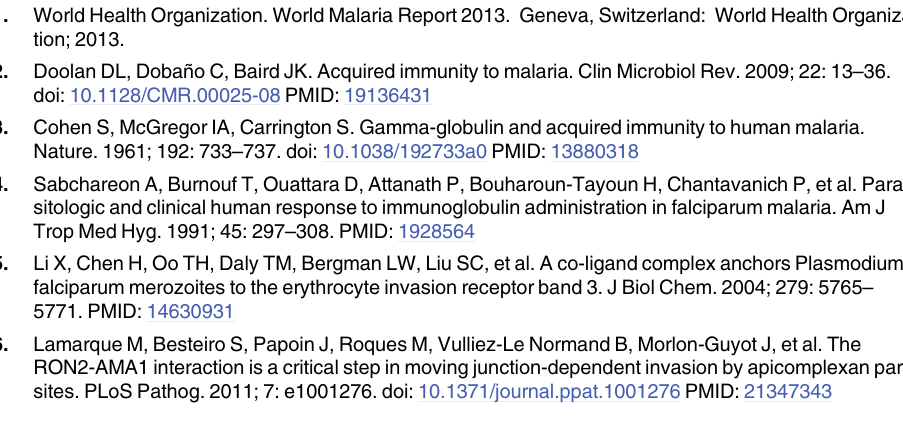
according to gender, 19